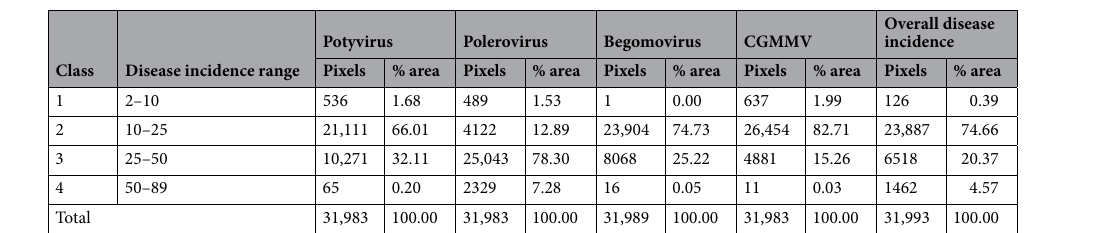
Table 3. Percentage of area categorized under each disease incidence